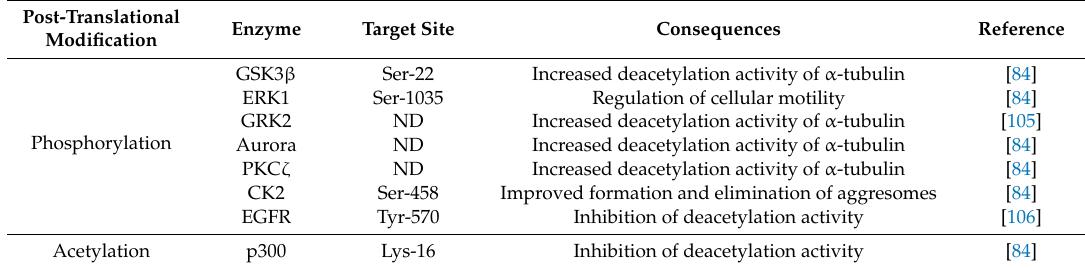
Table 5. Post-translational modifications regulating the activity of HDAC6.